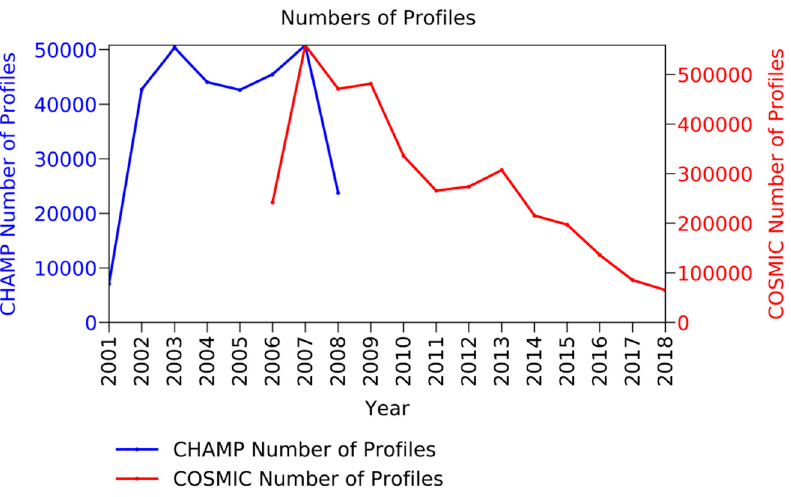
Figure 1. Numbers of electron density profiles. Blue: CHAMP (Challenging Minisatellite Payload), red: COSMIC (Constellation Observing System for Meteorology, Ionosphere, and Climate). Please note the different scales of the vertical axes for both satellite missions.